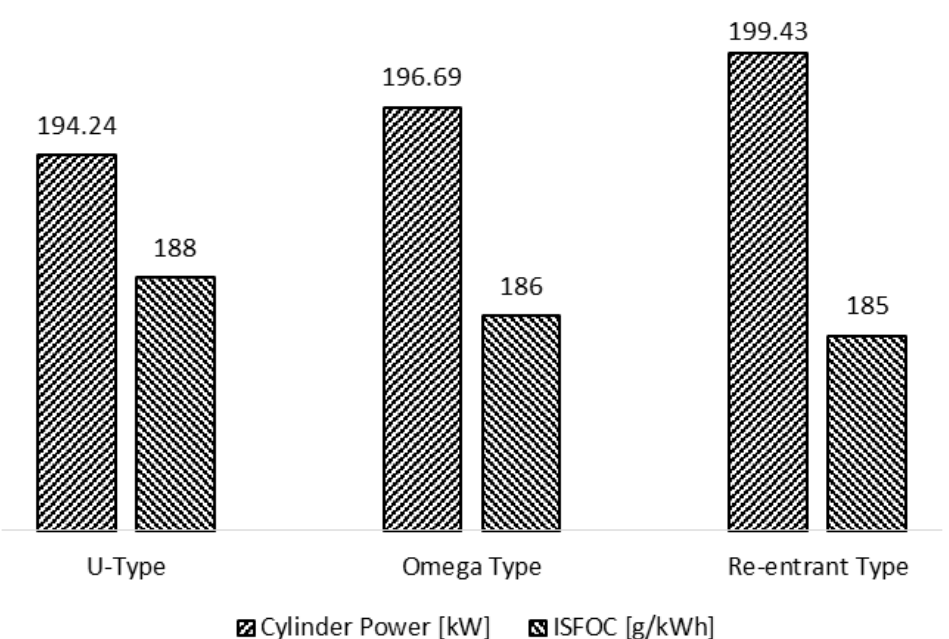
Figure 10. Cylinder powers and ISFOCs for the three various piston types.